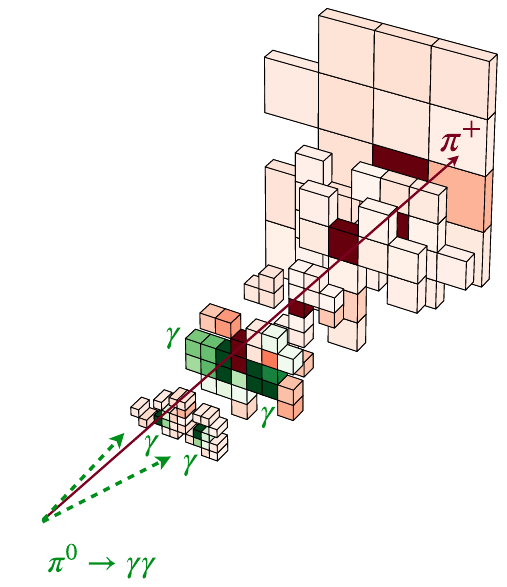
in red. The neutral energy deposits originating from the π 0 are other- wise illustrated in green. The extrapolation of the π + trajectory is also indicated